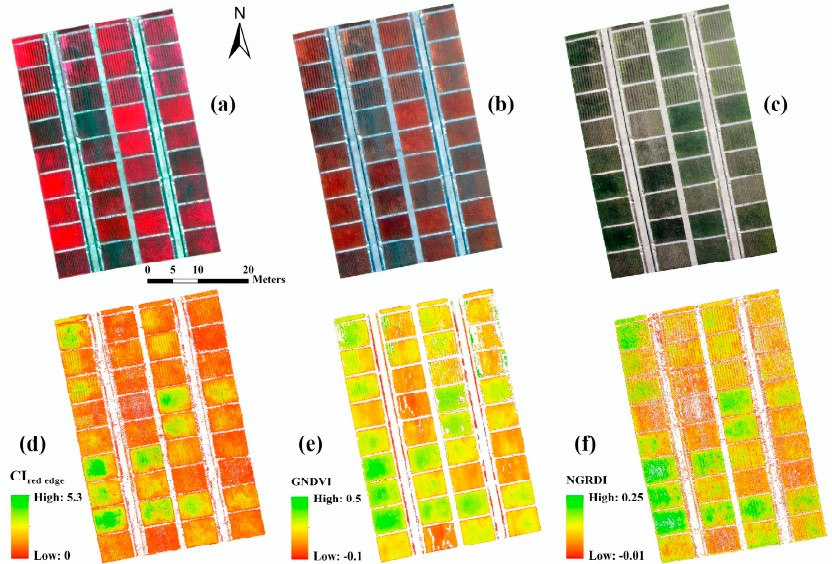
Figure 2. UAS images acquired from three cameras: MS image ( a ), CIR image ( b ) and RGB image ( c ) and their corresponding VI maps: red edge chlorophyll index (CI red edge ) map ( d ), GNDVI map ( e ) and NGRDI map ( f ). Study area (36 plots) was extracted from the three images. MS image is displayed with NIR, G and B bands.